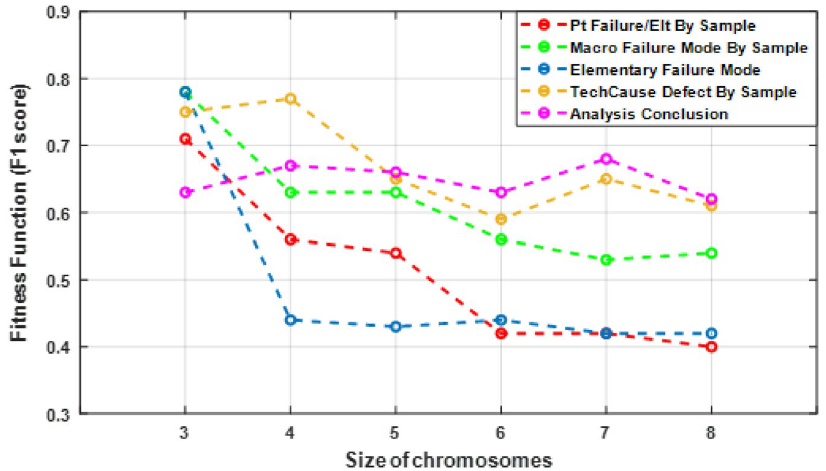
Figure 3. Values of GA-DT fitness functions for different sizes of L chromosomes. The optimal value is the highest F1 score.